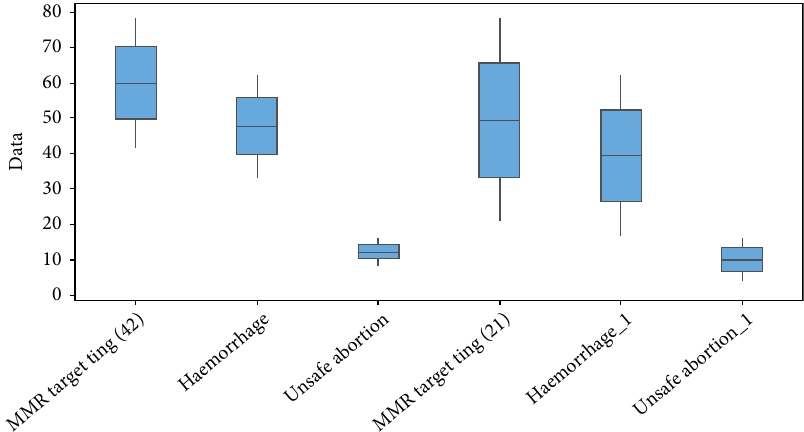
Figure 8: The boxplot presents min. values of MMR, minimum values of haemorrhage and minimum values of unsafe abortion, based on the UN target for MMR = 21 and 42, by 2030. Figure 7 displays Table 7 in graphic form. The reduction of haemorrhage significantly impacts MMR